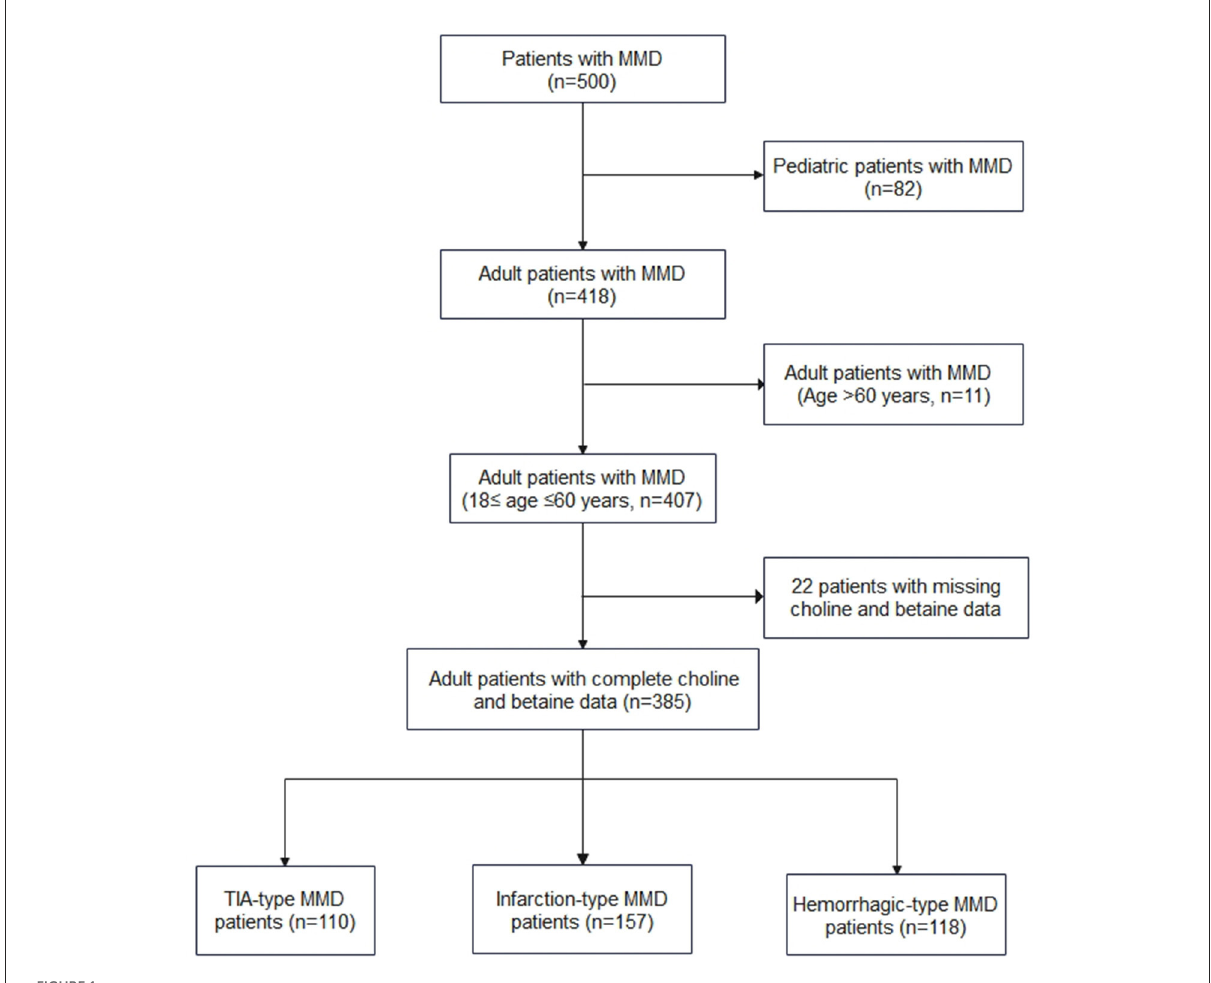
FIGURE1 Flow diagram of the study